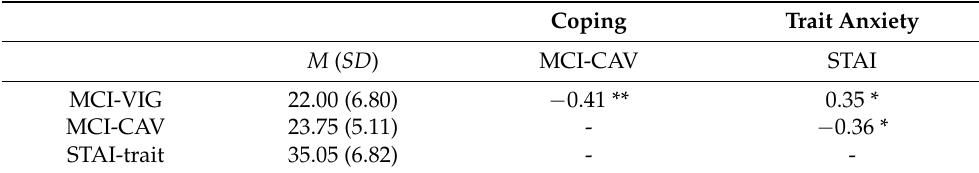
Table 1. Descriptive statistics and correlations ( df = 41) between psychometric measures. Coping Trait